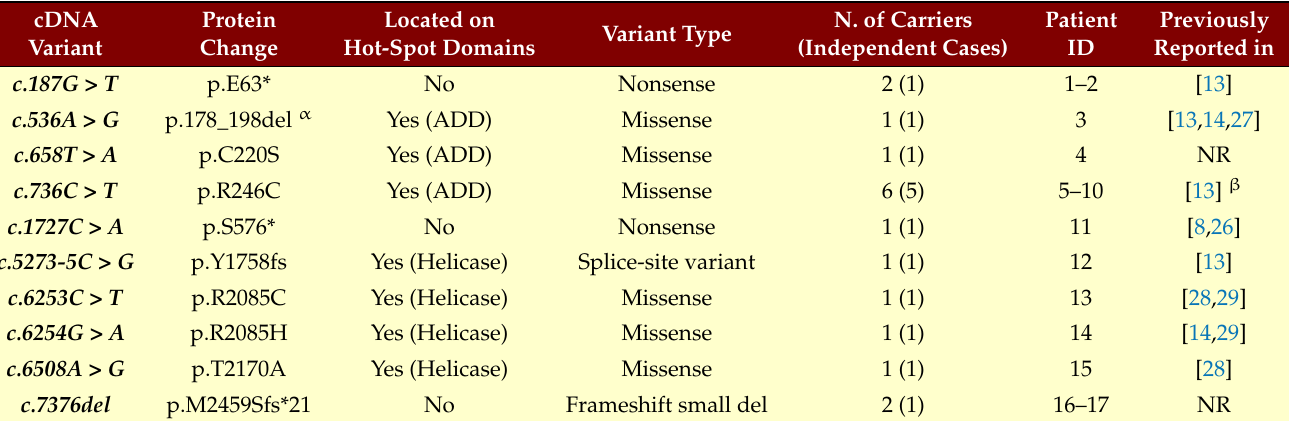
Table 1. Molecular details of the 10 variants represented in this